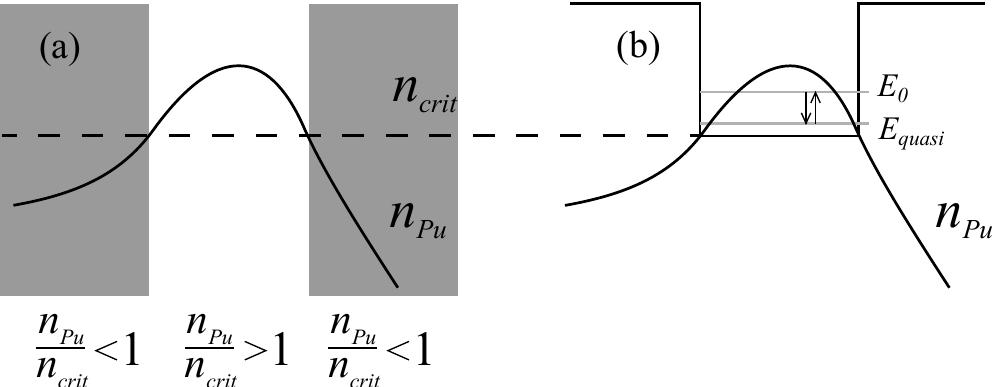
Figure 3. Schematic description of the permitted and forbidden region boundaries of nuclear burning according to the Borh-Sommerfeld condition ( a ) and the corresponding quasi-equivalent two-level scheme ( b